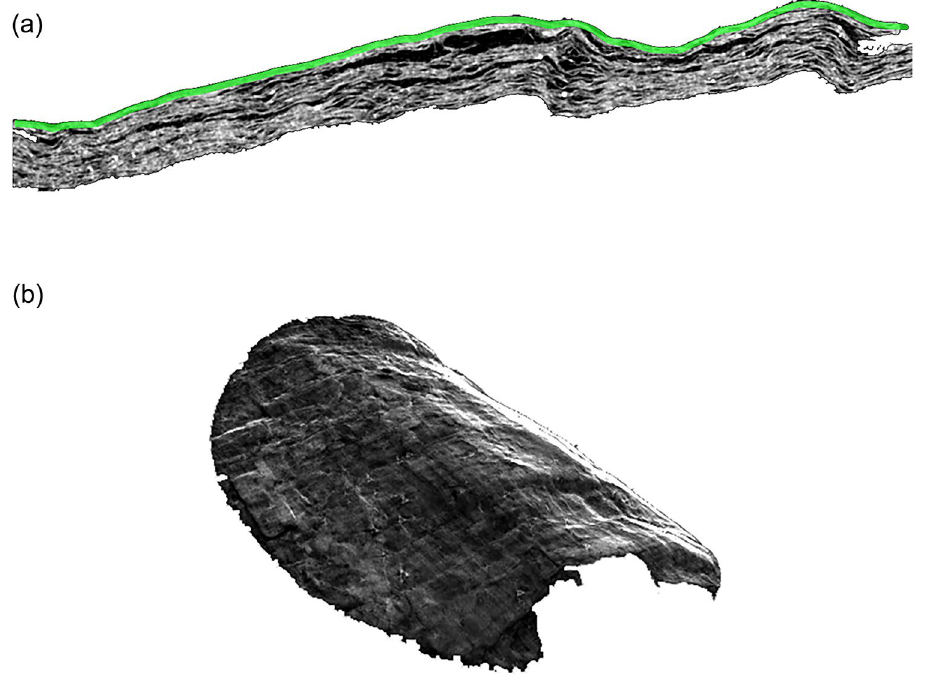
Figure 3. PHerc.110 image acquired using micro-CT. ( a ) The lateral section of the tomographic volume is overlaid with a segmented sheet (highlighted with the green line). ( b ) 3D rendering of the segmented